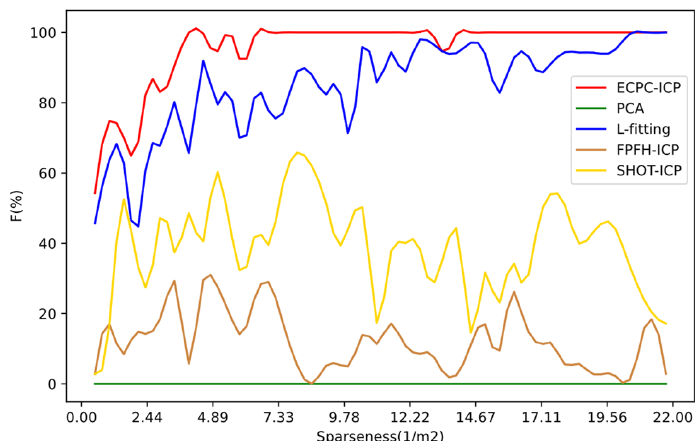
Figure 11. Pose estimation success ratio F of ECPC-ICP in different cases compared with other methods. Table 2. Pose estimation success ratio F of different methods in all cases.